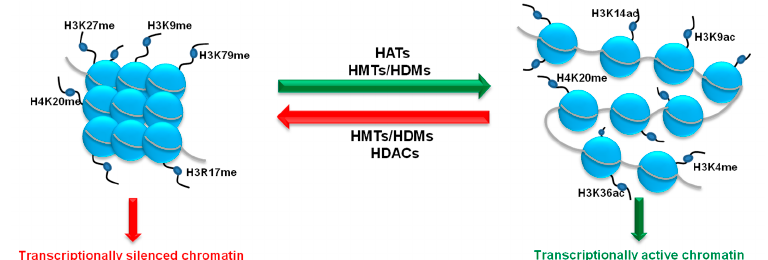
Figure 2. Histone methylation, in association to acetylation, regulate the chromatin transcriptional state. Histone lysine/arginine methyltransferases (HMTs), including EZH2, DOTL1 and G9a promote the formation of condensed and transcriptionally repressed chromatin. Histone demethylases (HDMs) in concert with histone acetyltransferases (HATs) and the histone H3K4 methylase SET7 promote the transcriptionally active chromatic state. Histone deacetylases (HDACs) contribute to transcriptional silencing (not discussed in this